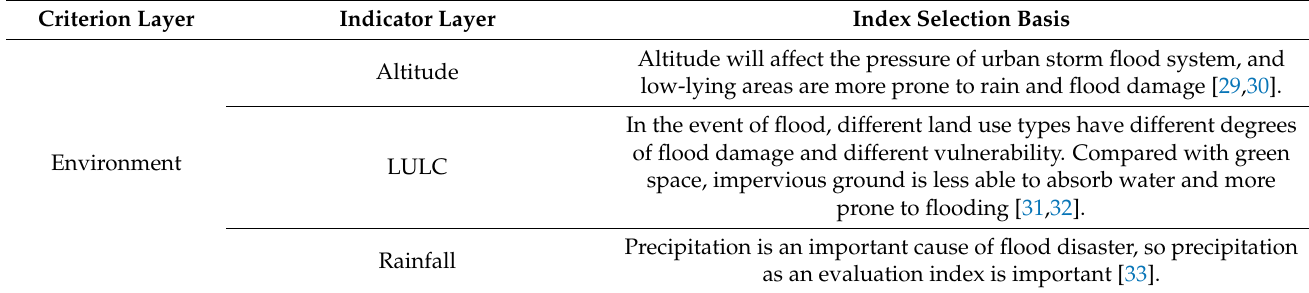
Table 1. Urban flood resilience evaluation index system and selection Table 1. Urban fl ood resilience evaluation index system and selection basis.